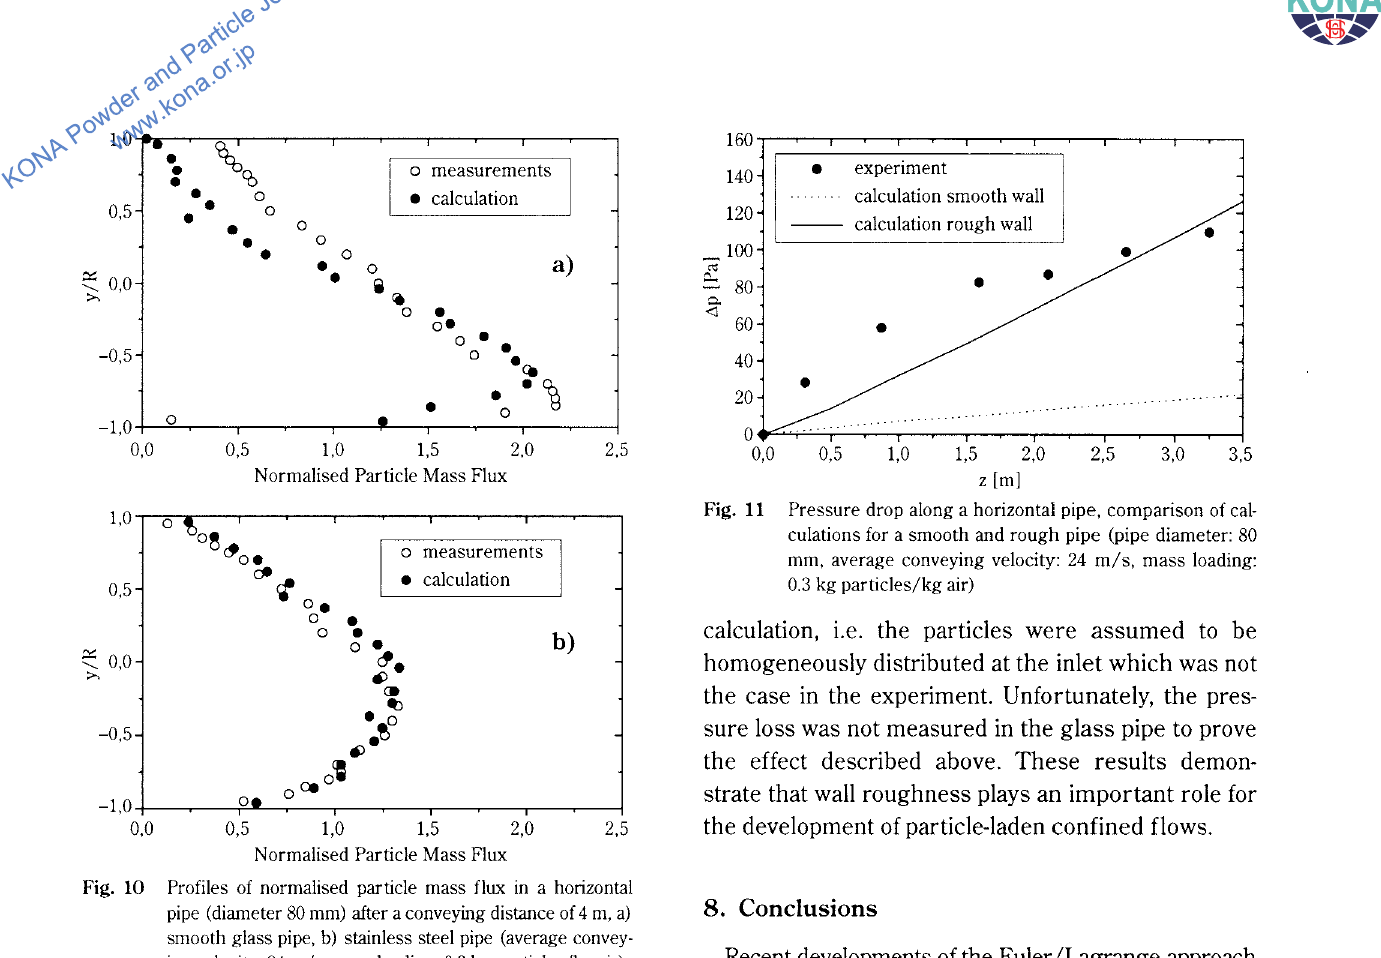
Fig. 11 Pressure drop along a horizontal pipe, comparison of cal culations for a smooth and rough pipe (pipe diameter: 80 mm, average conveying velocity: 24 m/s, mass loading: 0.3 kg particles/kg